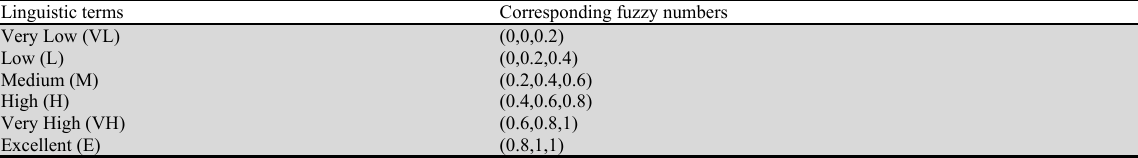
Linguistic scale for alternatives selection